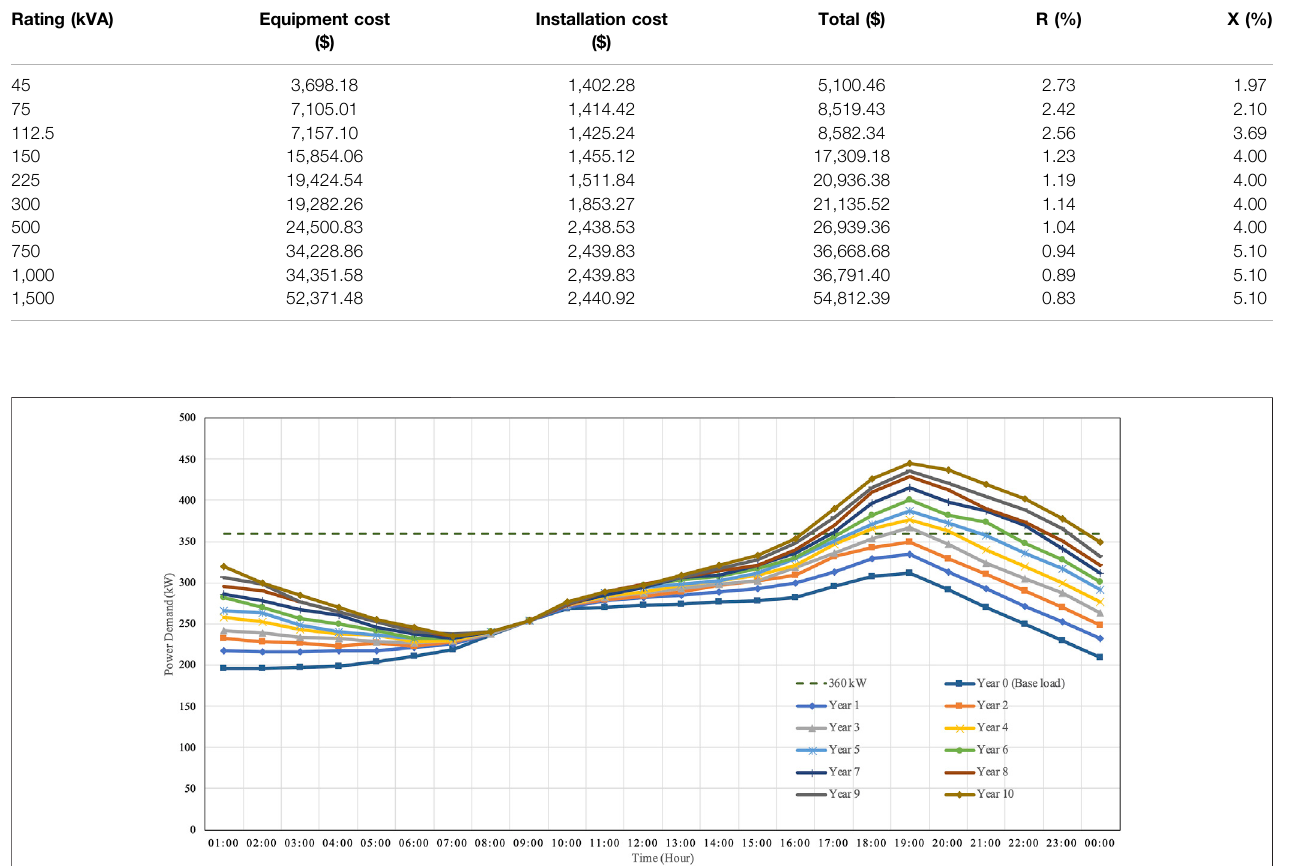
TABLE 2 | Size, price and installation cost of distribution transformer.